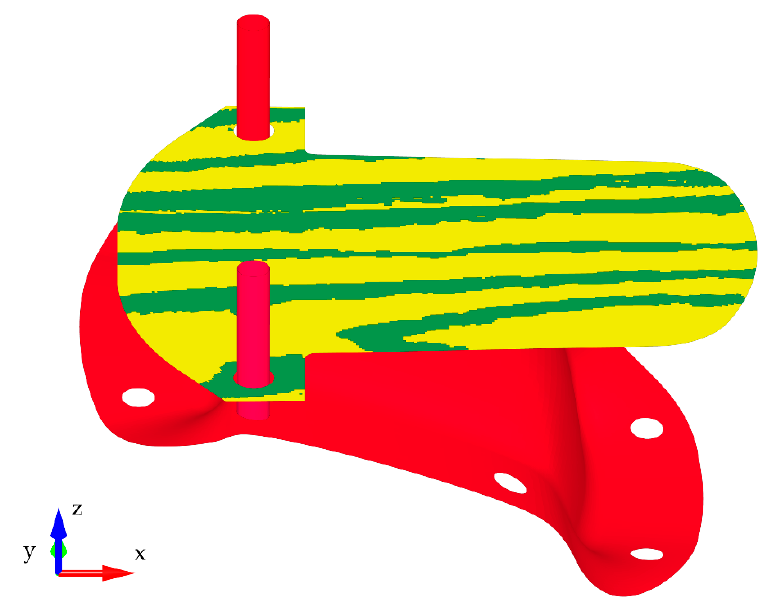
Figure 5. FE model of the gravity simulation.